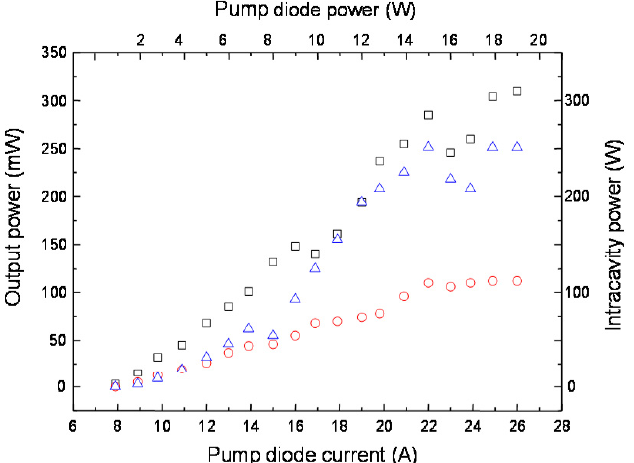
Fig. 7. Output of the scanning confocal Fabry P´erot analyzer showing the multilongitudinal modes of the linear cavity laser at λ 2 ω = 656